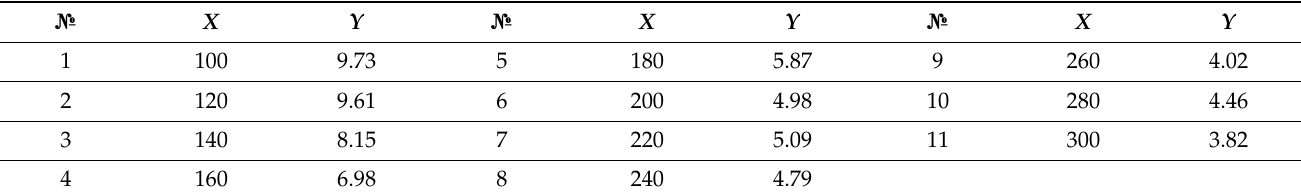
Table 1. Relationship between production lot size x and the average production cost per unit y